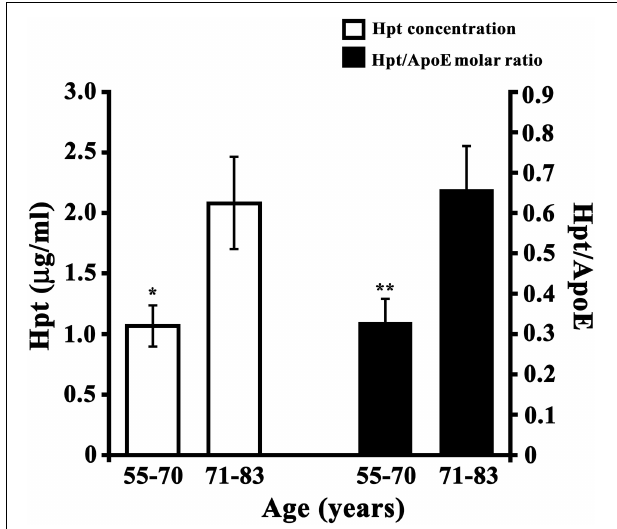
FIGURE 8 | Hpt concentration and Hpt/ApoE molar ratio in human CSF. Hpt and ApoE concentrations were measured, by ELISA, in human CSF samples obtained from younger subjects ( N = 13; aged 55–70 years) and older subjects ( N = 12, aged 71–83 years). Each sample was analyzed in triplicate. Data are reported as mean ± s.e.m. Significant differences between groups are indicated ( ∗ p = 0 . 02; ∗∗ p = 0 .